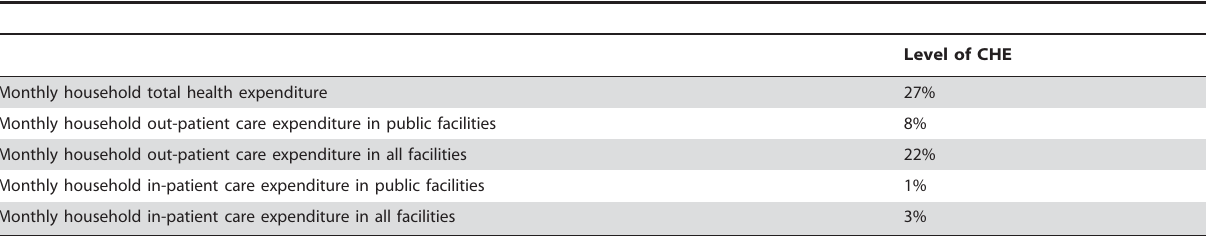
Table 3. Incidence of catastrophic expenditure for different